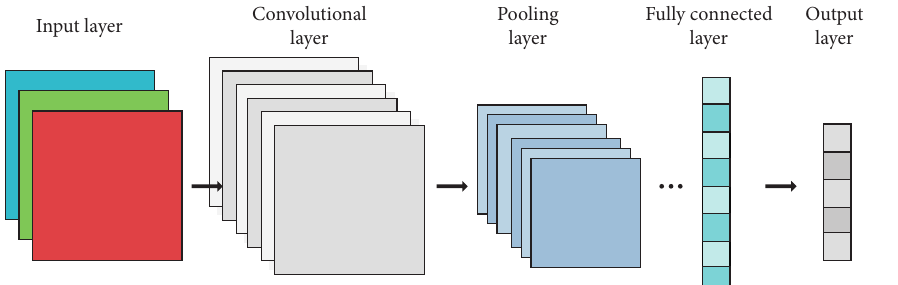
Figure 1: Structure of convolutional neural network for RGB image.